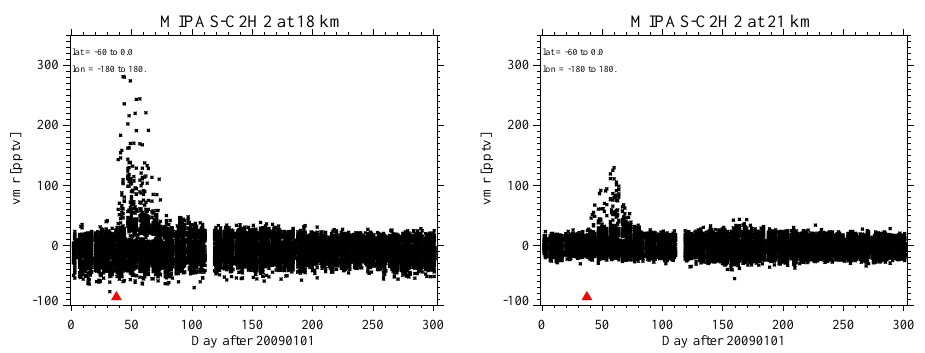
Fig. 2. MIPAS C 2 H 2 data in the latitude band 60 ◦ S to 0 ◦ N for the time period 1 January to 31 October 2009, measured at 18km (left) and 21km altitude (right). The red triangle indicates the date of the outbreak of the Australian bushfires (7 February).